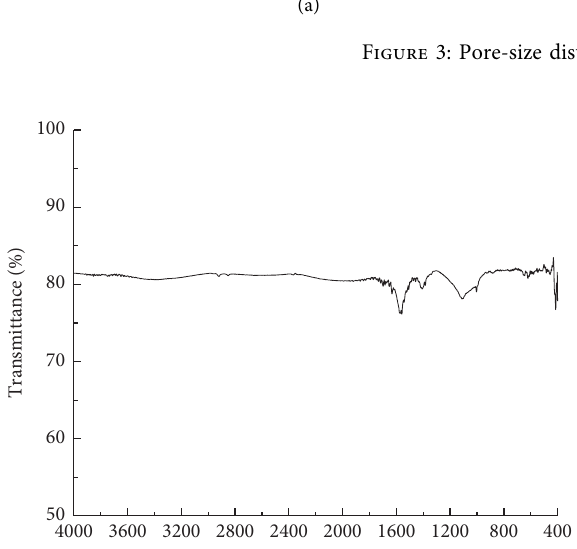
Figure 3: Pore-size distribution. (a) HK and (b) BJH.